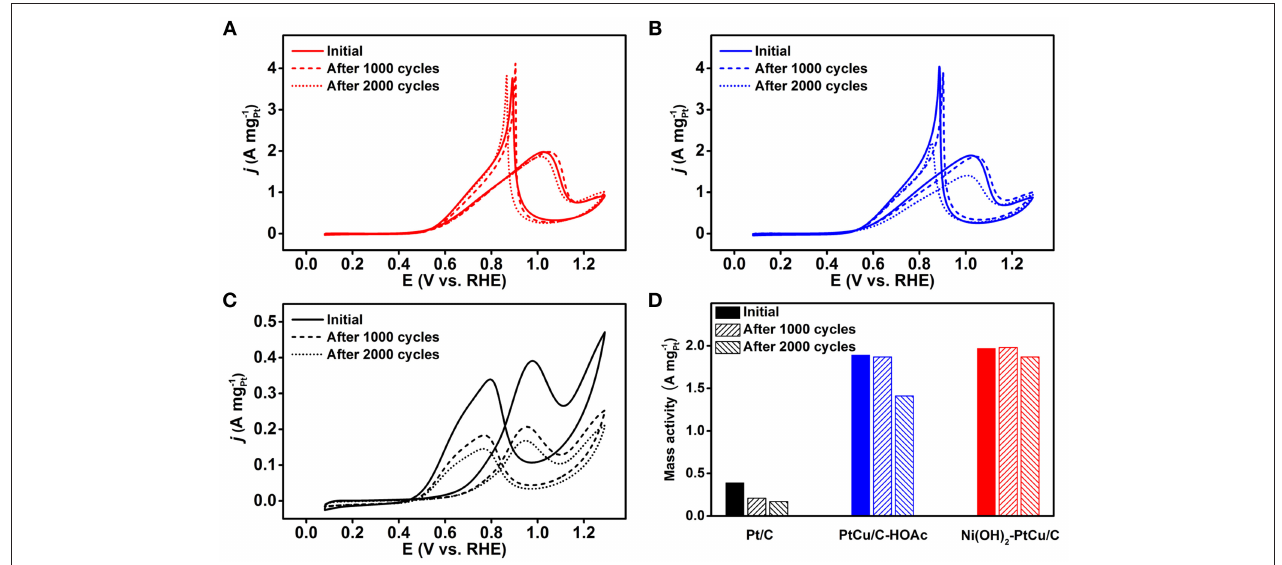
FIGURE 6 | CVs of (A) the Ni(OH) 2 -PtCu/C, (B) the PtCu/C-HOAc, and (C) the commercial Pt/C before and after the durability tests conducted under continuous potential cycling between 0.65 and 1.05V in Ar-saturated solutions containing 0.1M HClO 4 and 1.0M ethanol with a scan rate of 100mV s − 1 at room temperature. (D) Comparison of the mass activities of the three different catalysts before and after the durability test.